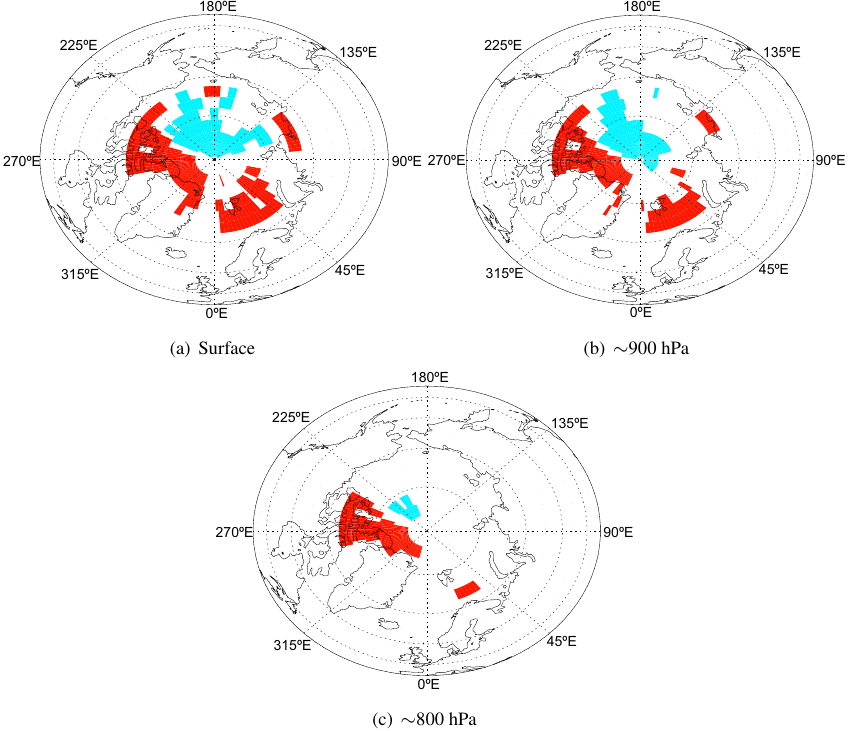
Fig. 5. Map of grid-boxes at (a) the surface (0-50 m), (b) ∼ 900 hPa (250-350 m) and (c) ∼ 800 hPa (400-500 m) used to calculate the budget terms shown in Table 2 and the size distributions shown in figure 7. Grid-boxes with a greater than 10% increase in CCN after sea-ice loss are shown in red, while grid-boxes with a greater than 10% decrease in CCN are shown in blue.